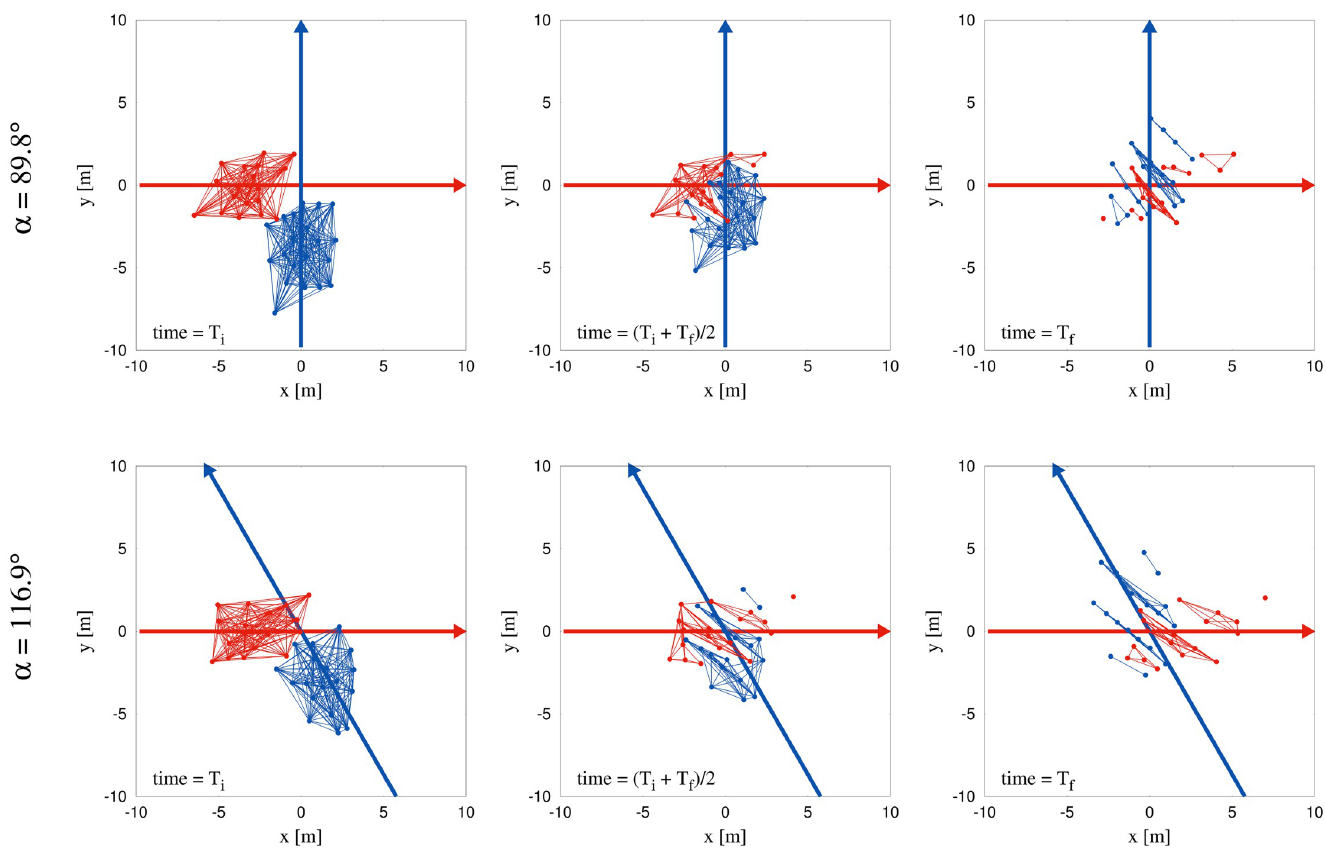
Fig 4. Pictorial representation of the edge-cutting algorithm. Figure demonstrates the working process of the edge-cutting algorithm as a sequence of time. Here we show the process for two typical trials with α = 89.8˚ and α = 116.9˚. Red and blue arrows indicate the direction of motion of the two groups represented by red and blue dots respectively. The lines connecting the dots in each of the groups are considered as the virtual bonds or ‘edges’ which are suppressed when cut by a pedestrian on the other group (see Materials and methods). The figures are shown for three instances, viz. T i , ( T i + T f )/2 and T f . T i and T f denote the instances of time when the first and last edge-cut take place respectively. The edge-cutting process for the entire course of time for these two trials are shown as videos in supplementary materials (S2 and S3 Videos).